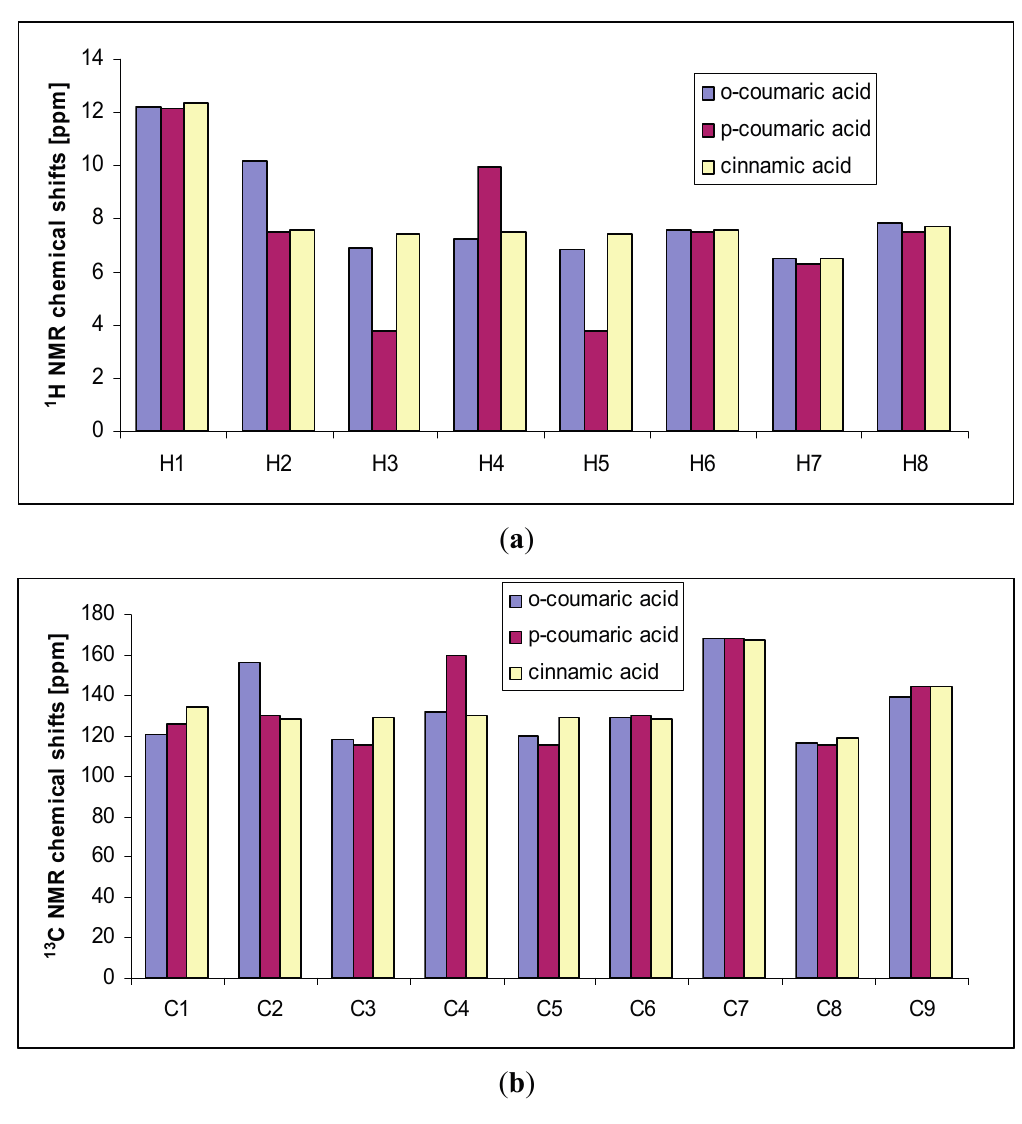
Figure 6. Experimental 1 H- ( a ) and 13 C-NMR ( a ) chemical shifts of trans o- coumaric acid, p- coumaric acid and cinnamic